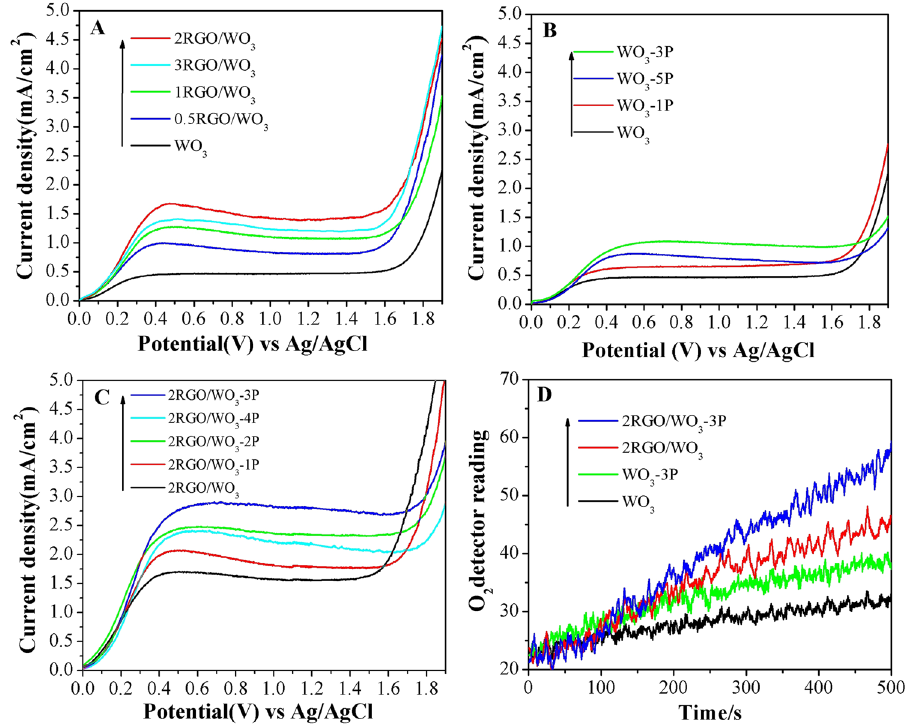
Figure 3. I-V curves of xRGO/WO 3 films ( A ), WO 3 -yP ( B ) and 2RGO/WO 3 -yP ( C ) under light irradiation, and PEC production curves of O 2 on WO 3 , WO 3 -3P, 2RGO/WO 3 and 2RGO/WO 3 -3P ( D ). Potentials were measured in 0.5 M Na 2 SO 4 electrolyte solution. A three-electrode cell was used with the testing film as the working electrode, Ag/AgCl (saturated KCl solution) as the reference electrode, and Pt plate as the counter electrode.